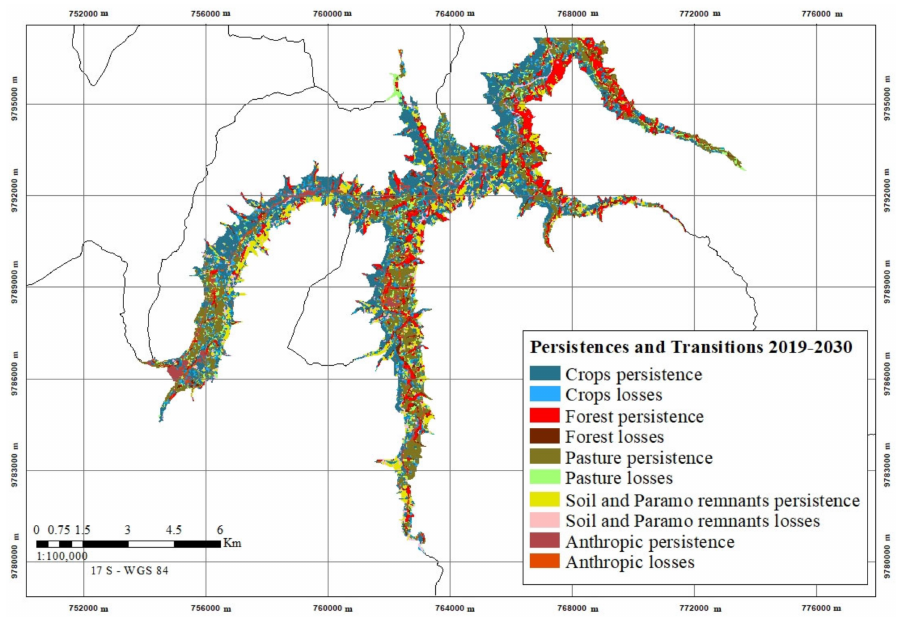
Figure 9. Map of coverage persistence and transitions between 2019 and 2030. Table 12. Coverage transitions in terms of area in the time interval of